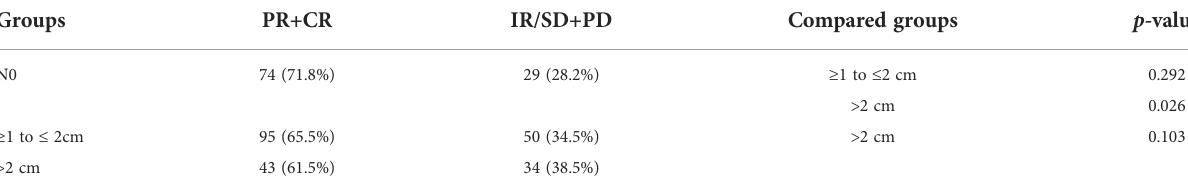
TABLE 2 Correlation between the nodal size and the response to treatment.